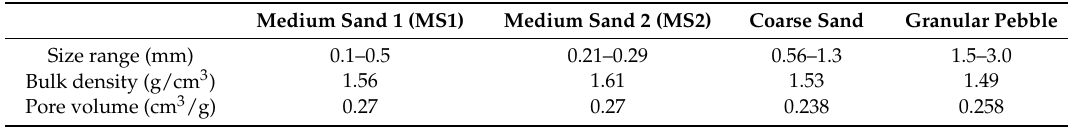
Table 1. Summary of silica sand properties.